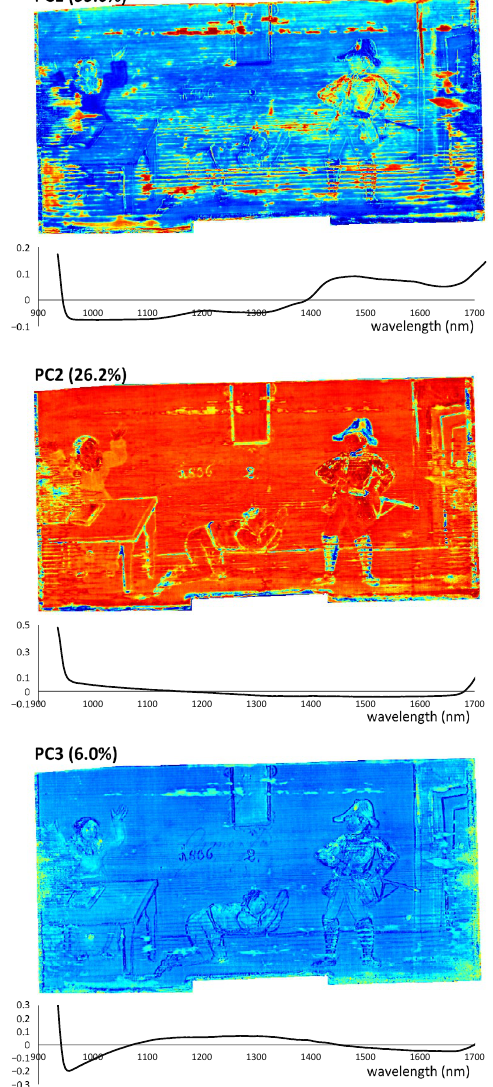
Figure 3. Results of PCA for images taken in the NIR spectral range. Note: The percentages in parentheses explain the variances of all the individual principal components.